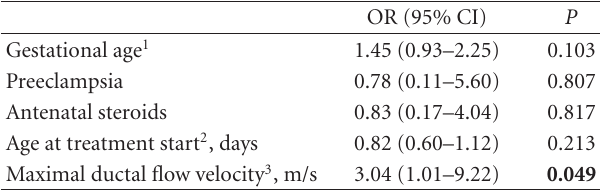
Table 4: Multivariable analysis for ductal